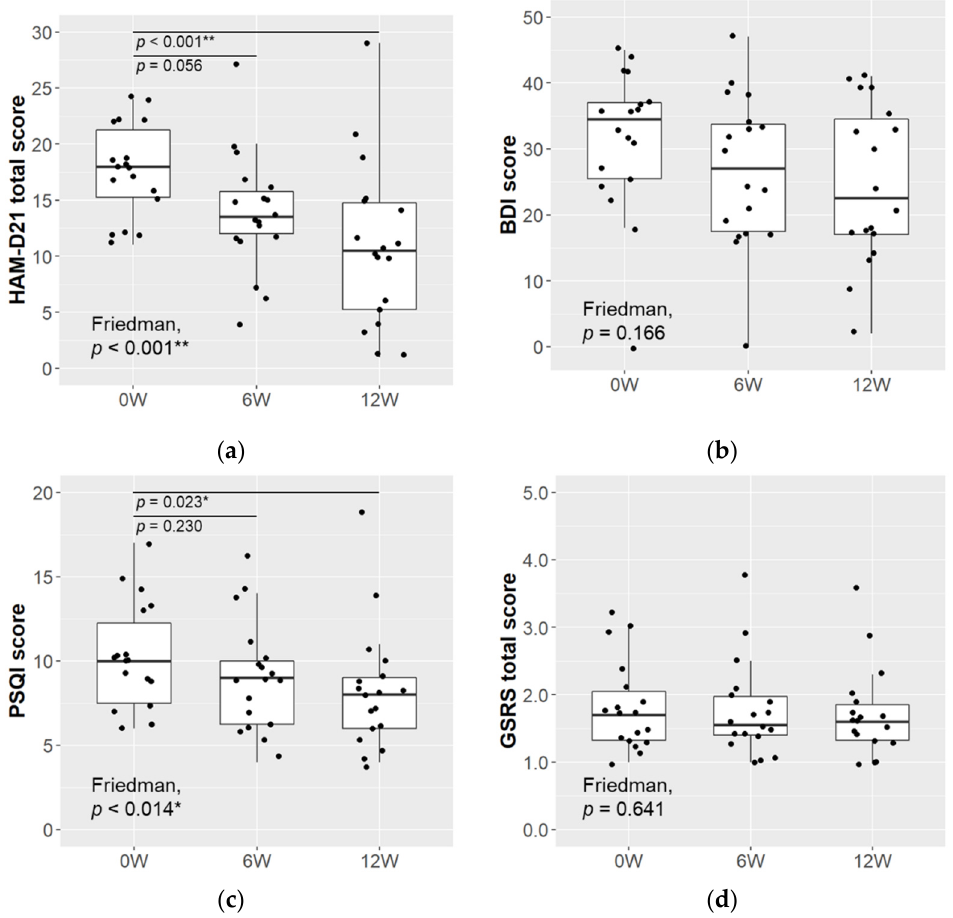
Figure 1. Changes in rating scales of depressive, sleep, and gastrointestinal symptoms. Depressive symptoms scores evaluated by ( a ) HAM-D21 and ( b ) BDI; sleep quality and sleep disturbance rated by ( c ) PSQI; GI symptoms score evaluated by ( d ) GSRS ( n = 18). The Friedman test was used for the multiple comparisons between time points, and when significance was observed, the Nemenyi test was conducted post hoc for pairwise comparisons with the baseline data (* p < 0.050, ** p <